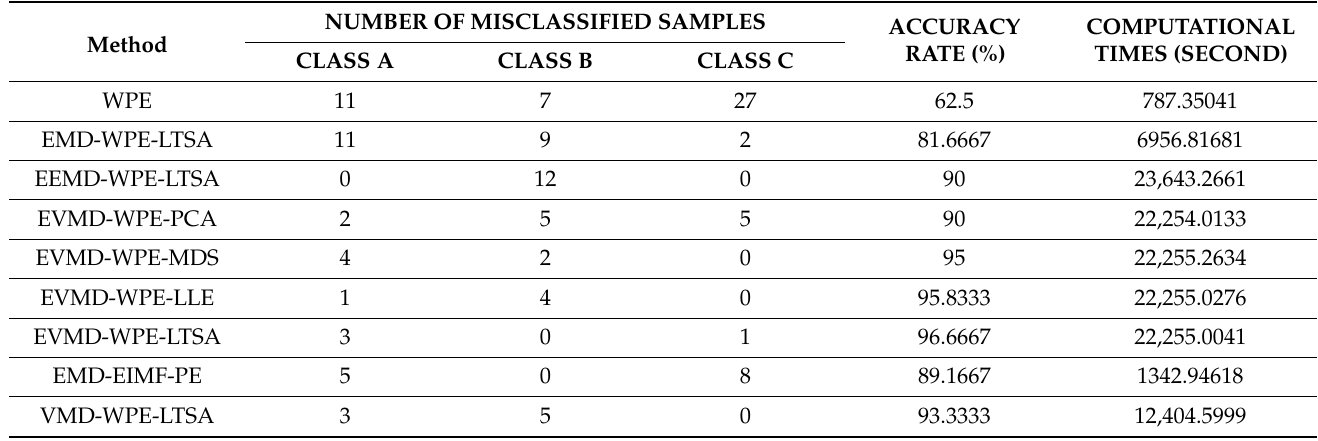
Figure 17. The scatter plots of the three algorithms. ( a ) WPE; ( b ) EMD-WPE-LTSA; ( c ) EEMD-WPE- LTSA. Table 3. The classification accuracy and computational complexity under different